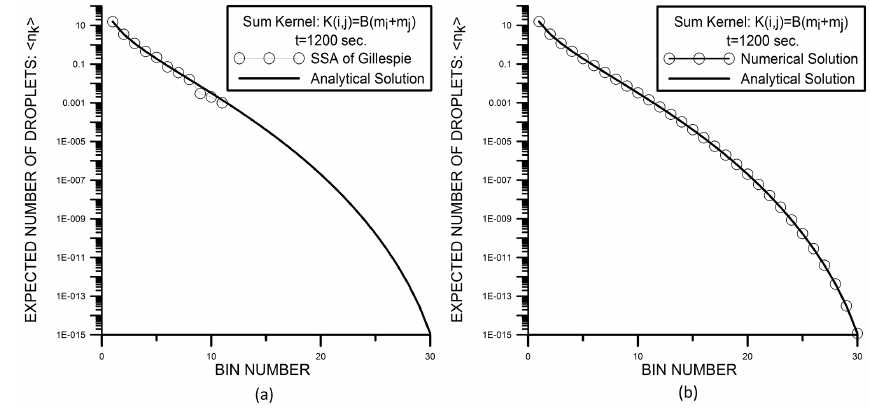
Figure 5. At t = 1200s, comparison between the droplet size distributions obtained from the analytical solution of the master equation (line) and (a) the SSA of Gillespie for 10 3 realizations (circles) and (b) the numerical algorithm (circles). Calculations were performed with the initial condition P( 30 , 0 , 0 , 0 ,..., 0 ; 0 ) = 1 for the sum kernel K(i,j) = B(x i + x j ) , with B = 8 . 82 × 10 2 cm 3 g − 1 s − 1